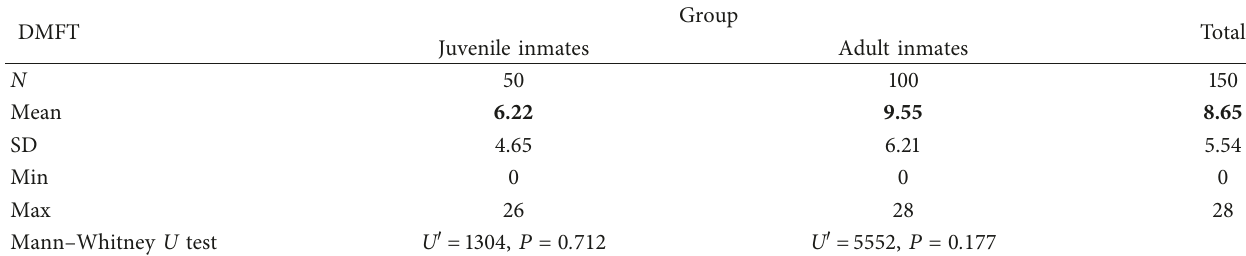
Table 1: DMFT values according to the groups.